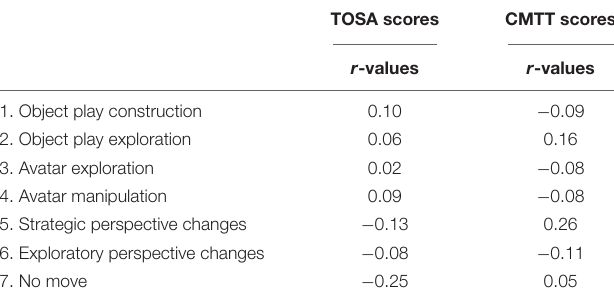
TABLE 6 | Correlations between spatial skill assessment scores and the proportion of play time younger (TOSA scores) and older (CMTT scores) children spent engaging in each type of play